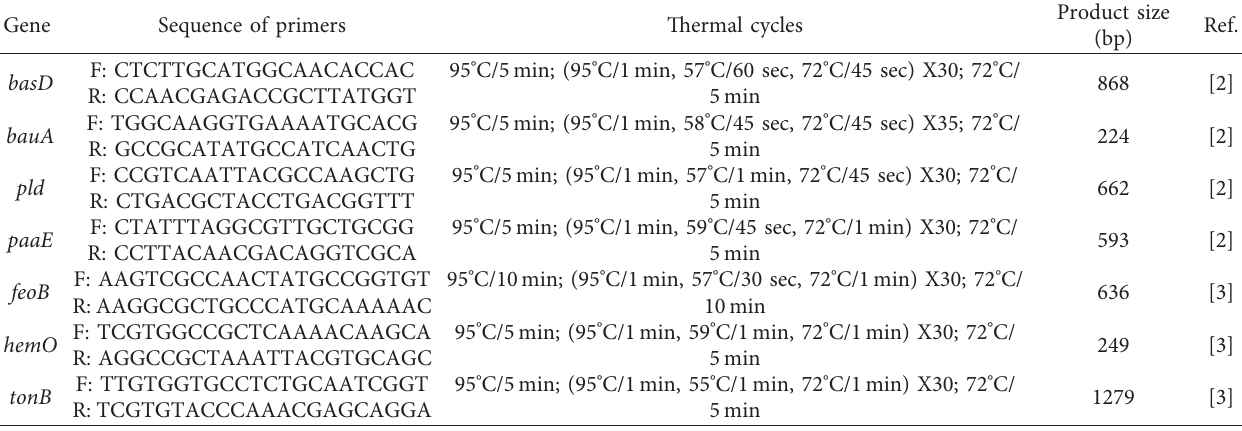
Table 1: Oligonucleotide sequences used in this study and thermal cycling conditions.